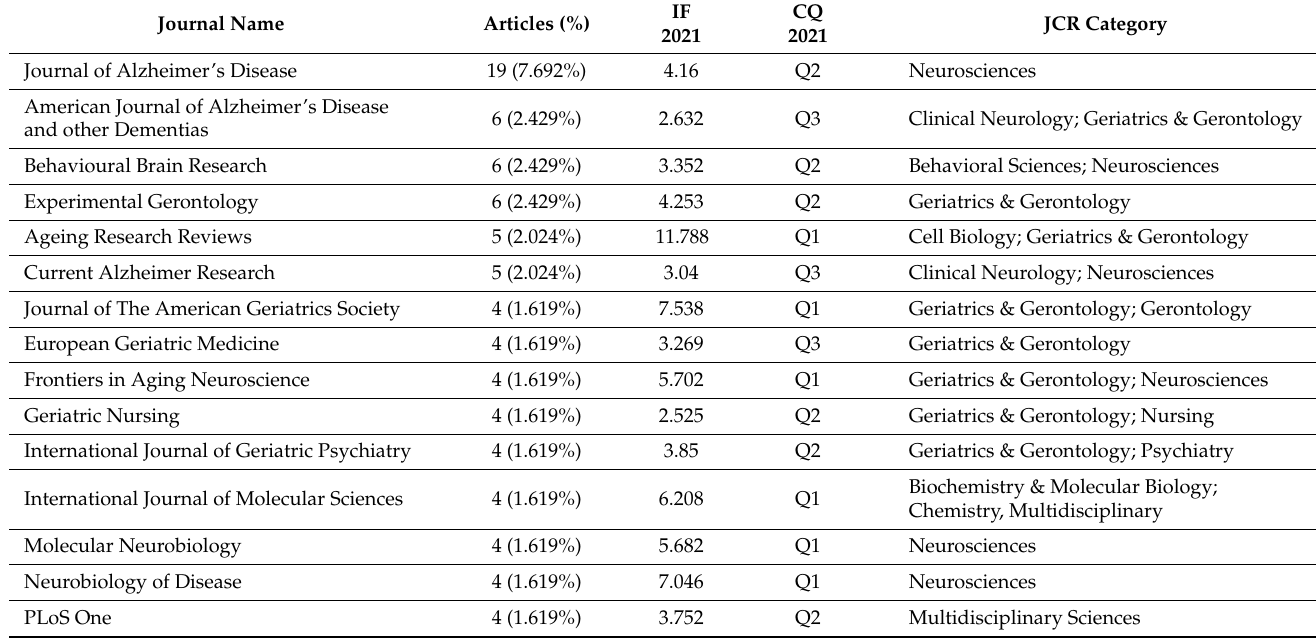
Table 1. The top 15 most productive journals for AD exercise research